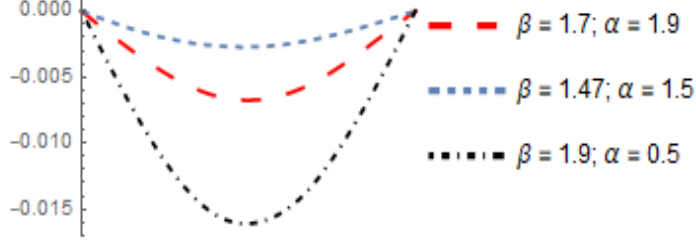
Figure 1. The comparison of the solution (13) at , c 1 = 0.5, c 0 = − 1.8 for different α and β